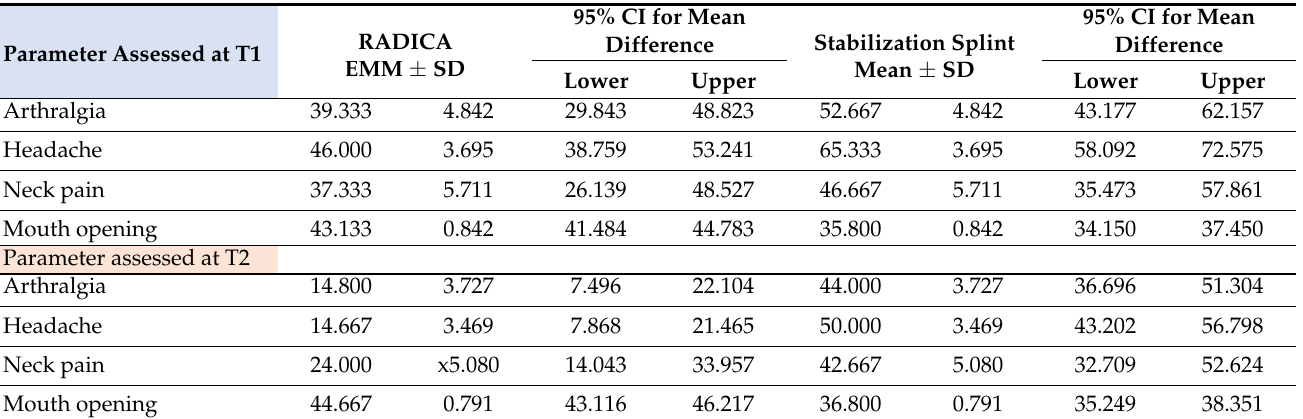
Table 2. Estimated Marginal Means (EMM) for each treatment and time (T1 and T2) with 95% Confidence Interval (CI).